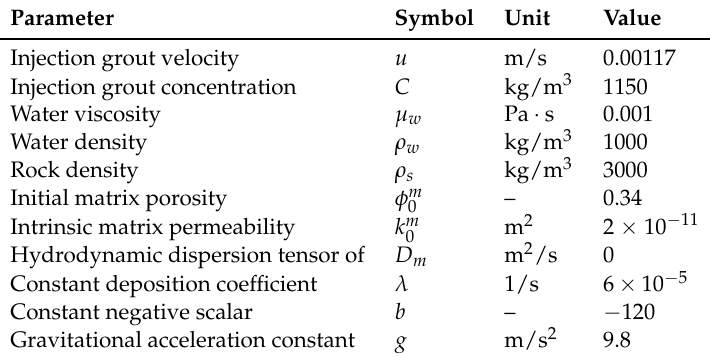
Table 1. Parameters for the experimental verification simulation.